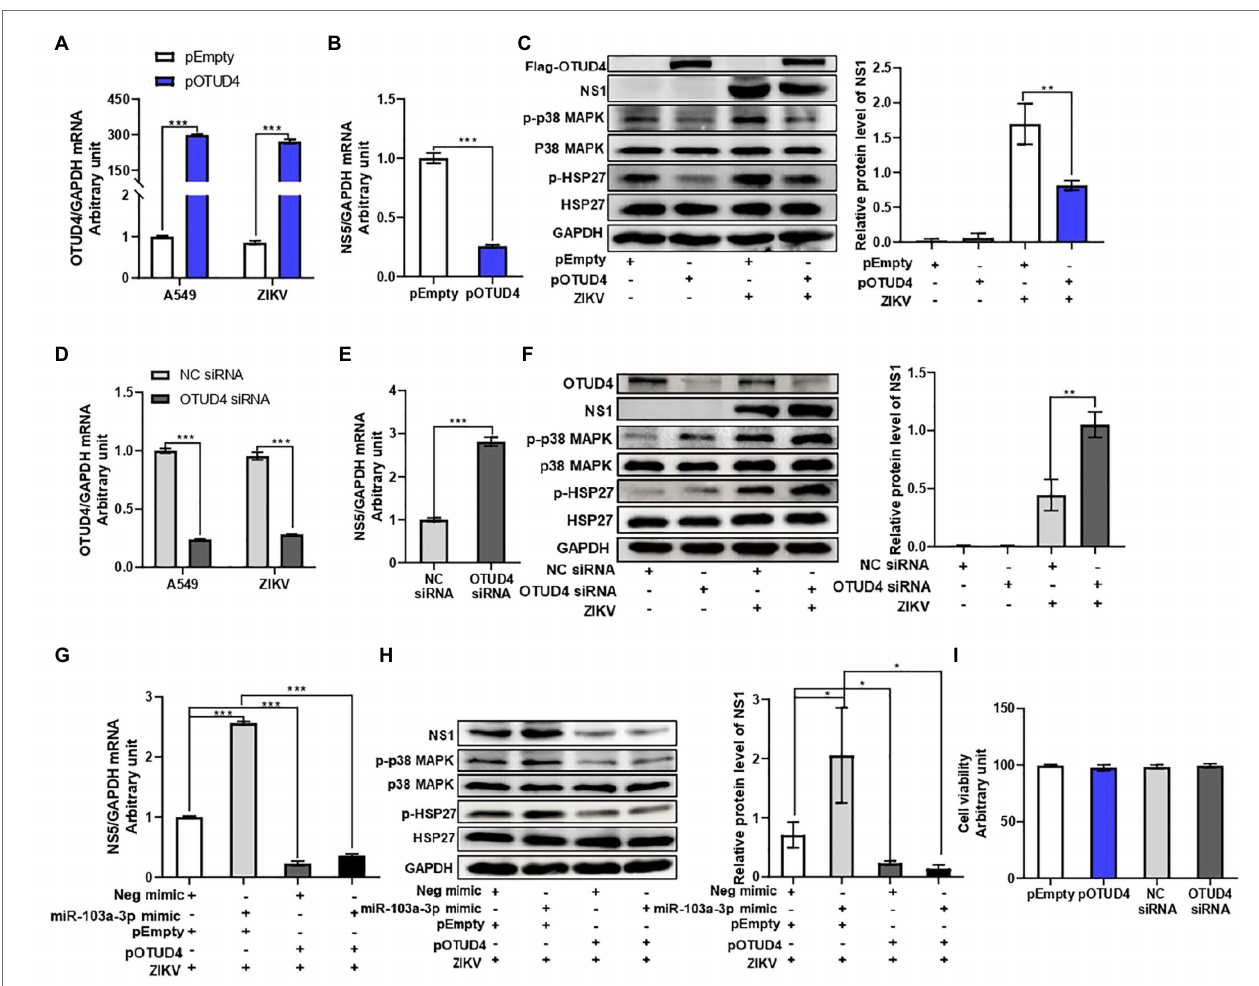
FIGURE 5 | OTU deubiquitinase 4 regulates ZIKV replication through activating p38 MAPK signaling pathway. pOTUD4, OTUD4 siRNA and corresponding control were transfected into A549 cells and then cells were infected ZIKV (MOI = 0.5). Total RNA and protein of cells were harvested at 48 h post infection for qRT-PCR and Western blot analysis, respectively. (A) The mRNA expression level of OTUD4 is significantly increased following pOTUD4 transfection compared to pEmpty. (B) OTUD4 over-expression inhibits ZIKV NS5 mRNA expression compared to pEmpty. (C) Over-expression of OTUD4 decreases ZIKV NS1, p-p38 MAPK, and p-HSP27 protein levels compared to pEmpty. (D) The mRNA expression level of OTUD4 is inhibited by OTUD4 siRNA transfection compared to NC siRNA. (E) OTUD4 knock-down significantly promotes ZIKV RNA expression compared to NC siRNA. (F) Silencing of OTUD4 increases ZIKV NS1, p-p38 MAPK, and p-HSP27 protein levels compared to NC siRNA. (G) Over-expression of OTUD4 abrogates the stimulating effect of miR-103a- 3p on ZIKV RNA replication. (H) OTUD4 over-expression reduces the promoting effect of miR-103a-3p on ZIKV NS1, p-p38 MAPK, and p-HSP27 protein levels. (I) pOTUD4 and OTUD4 siRNA transfection into A549 cells did not affect cell viability. Data are presented as mean ± SD. Error bars indicate SD ( n ≥ 3). * p < 0.05, ** p < 0.01 and *** p <